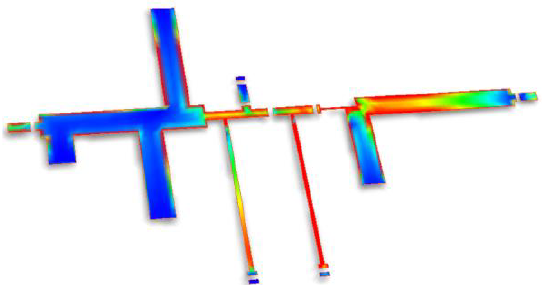
Fig. 23. EM-circuit excitation result @ the fundamental tone